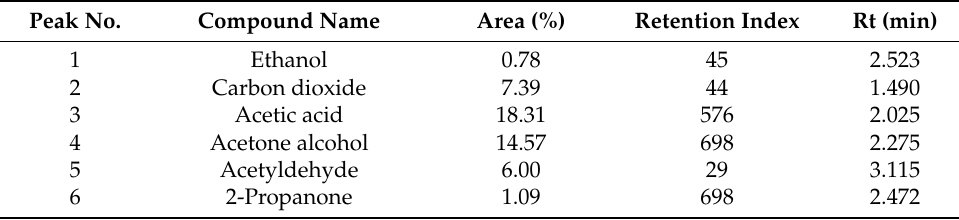
Table 2. Mass spectrometry-based identification of the fermentation products generated during the co-culture of B. altitudinis RSP75 with Saccharomyces cerevisiae . Peak No. Compound Name Area (%) Retention Index Rt (min) 1 Ethanol